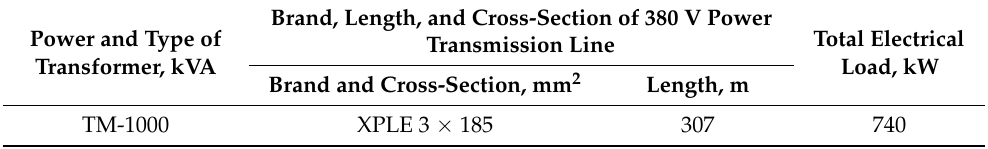
Table 4. Parameters of the model.